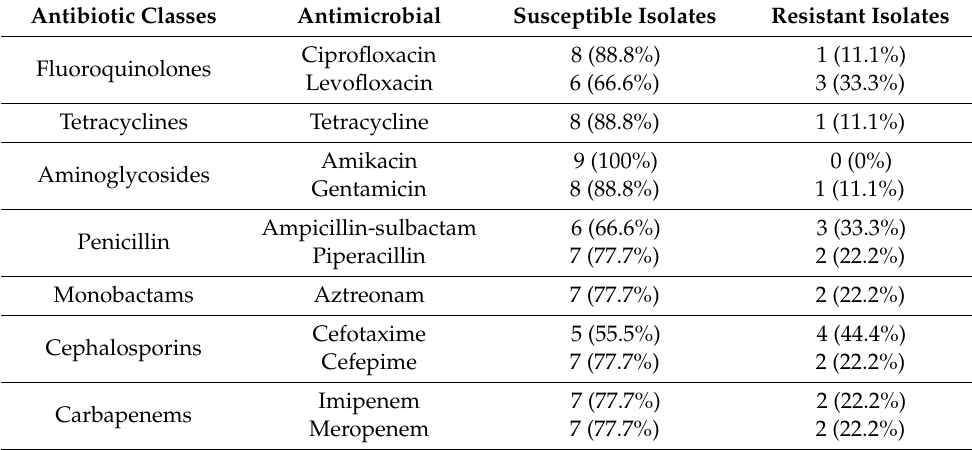
Table 2. Antimicrobial susceptibility profiles of A. baumannii isolates. Table 2 . Antimicrobial susceptibility profiles of A. baumannii isolates. Antibiotic Classes